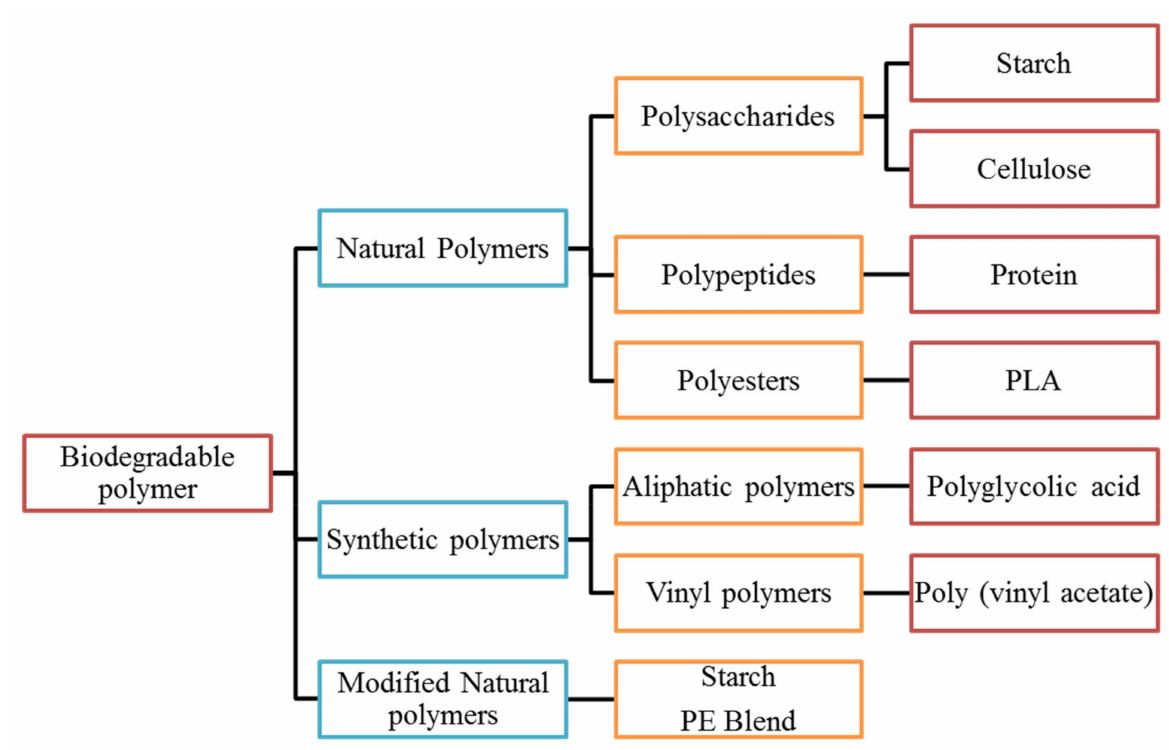
Figure 1. Schematic representation of biodegradable polymers based on their origin